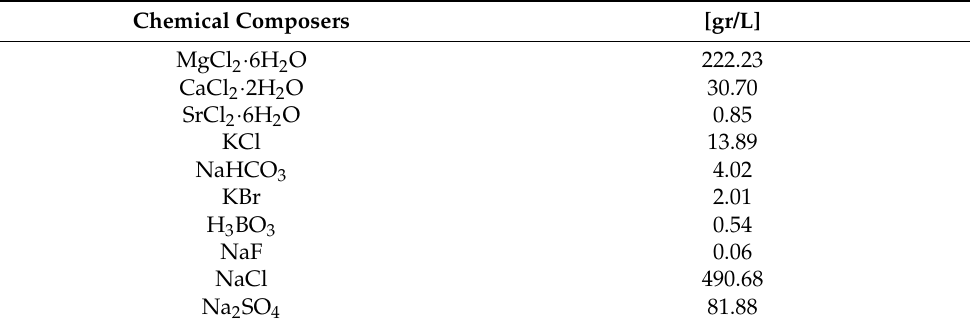
Table 1. Composition of artificial sea water (solvent: distilled